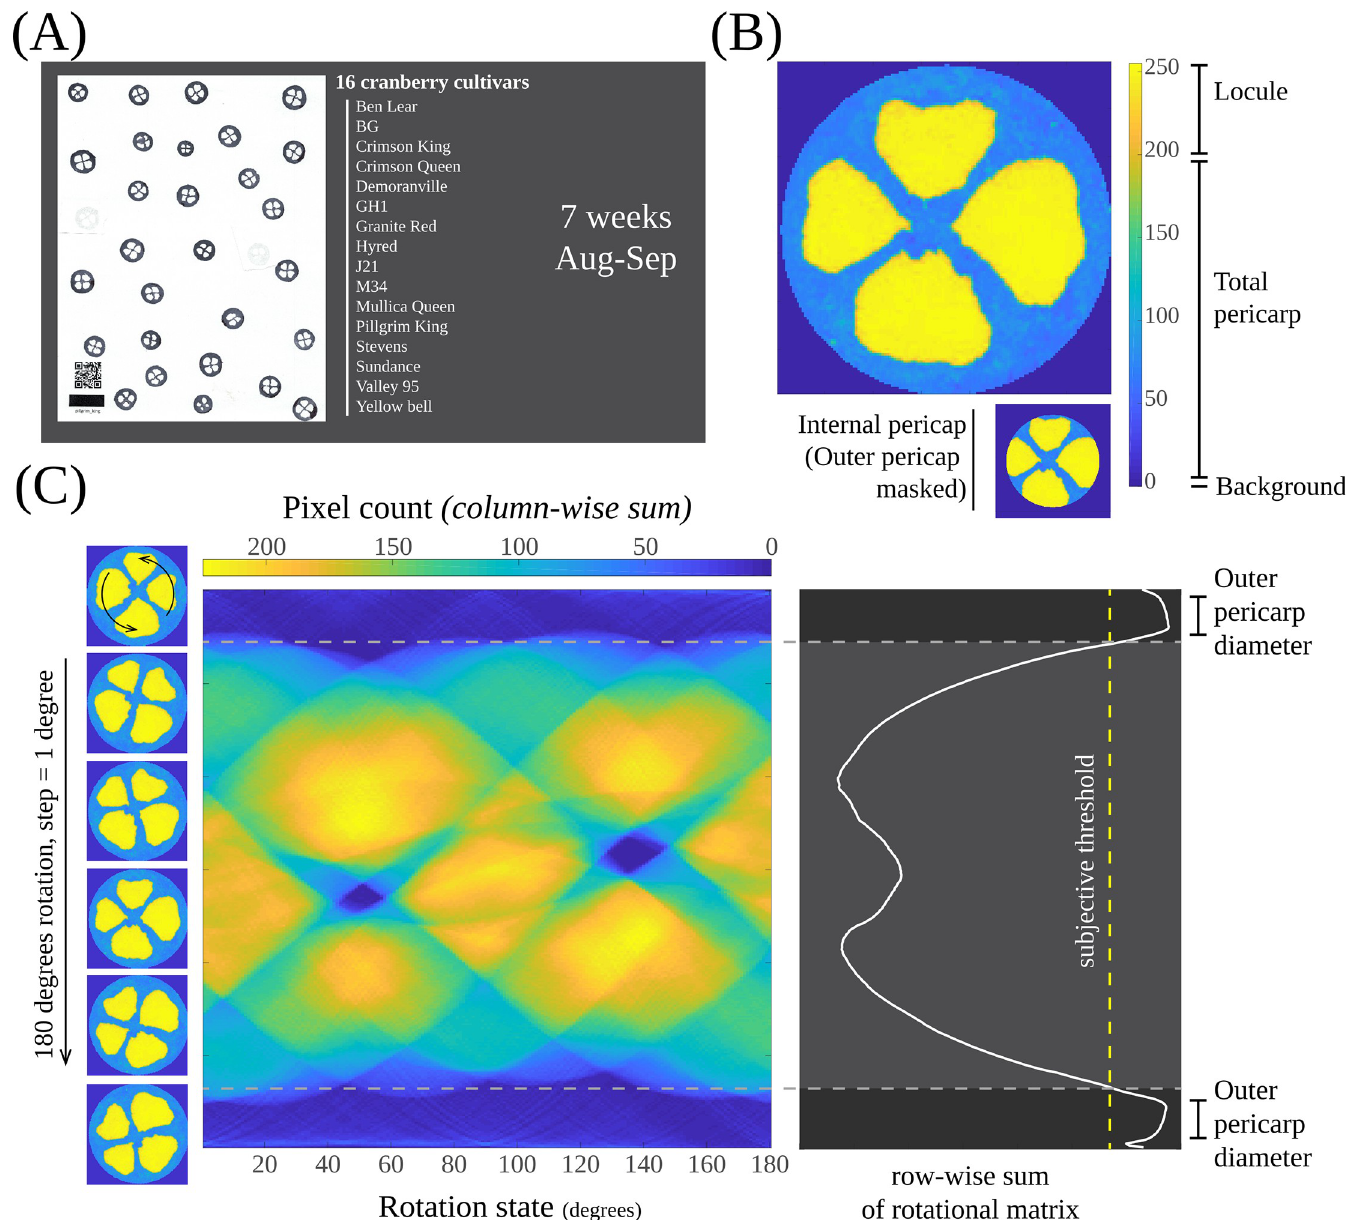
Fig 1. Fruit structure parameters measured through computer vision. (A) A set of fruit (N > 25) from 16 cranberry cultivars were equatorially cut, and a single ink stamp per fruit was imprinted on paper. QR codes (for automating image processing) and size reference were included on each page. (B) Background, total pericarp area and locules were differentially flagged to estimate fruit structure parameters. (C) Outer pericarp diameter was obtained by computationally rotating each fruit stamp and analyzing the horizontal pixel